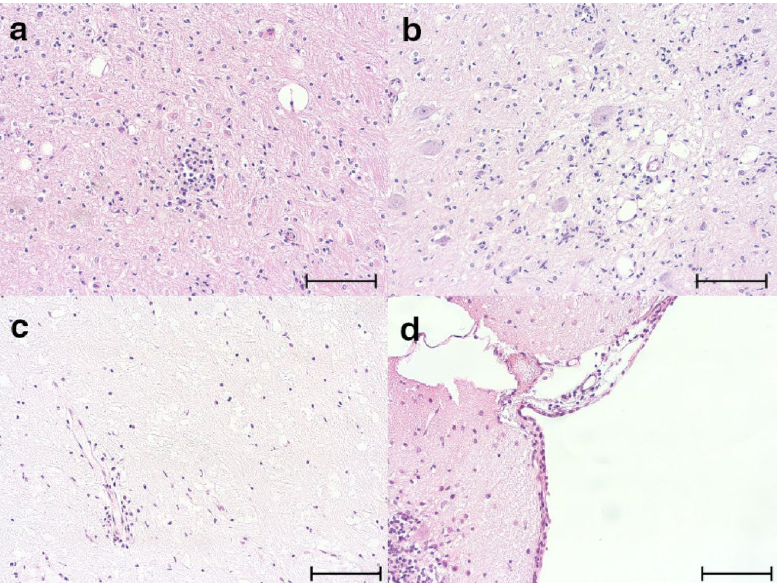
Figure 1. Histological lesions in fox brains. ( a ) Nodular gliosis, cerebellum. ( b ) Diffuse gliosis and vacuolization, cerebrum. ( c ) Mild perivascular lymphohistiocytic cuffing, cerebrum. ( d ) Meningeal lymphohistiocytic infiltrates, brainstem. ( a – d ) H&E staining. Scale bars = 100 µm.